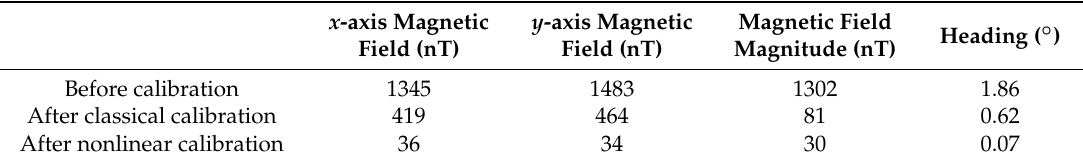
Table 1. The maximum error before and after